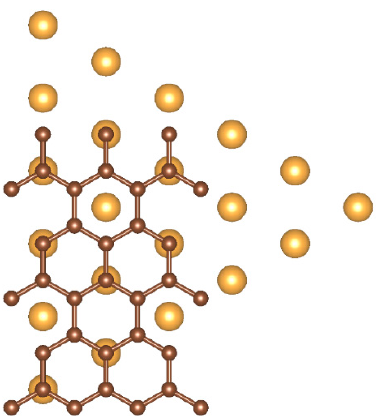
Figure 2. Top-down view of the ideal interface between the (111) triangular facet of the Au 561 NPs and graphene.